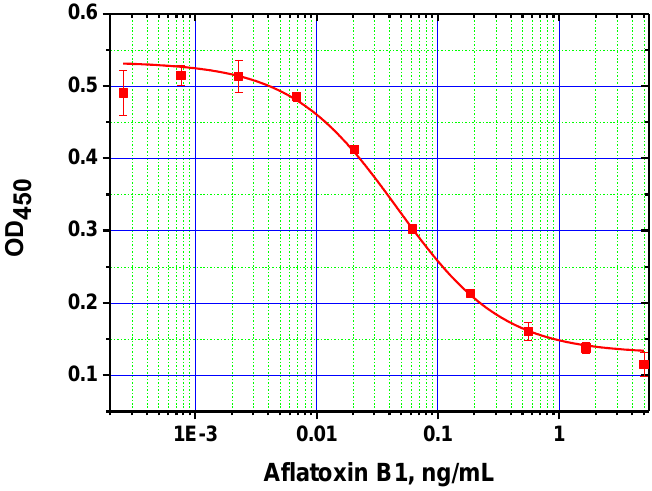
Figure 4. Calibration curve of MNP-based ELISA for AFB1 detection using 5-min incubation period for immune interaction. A limit of detection of 10 pg/mL was obtained. The measurements were performed in